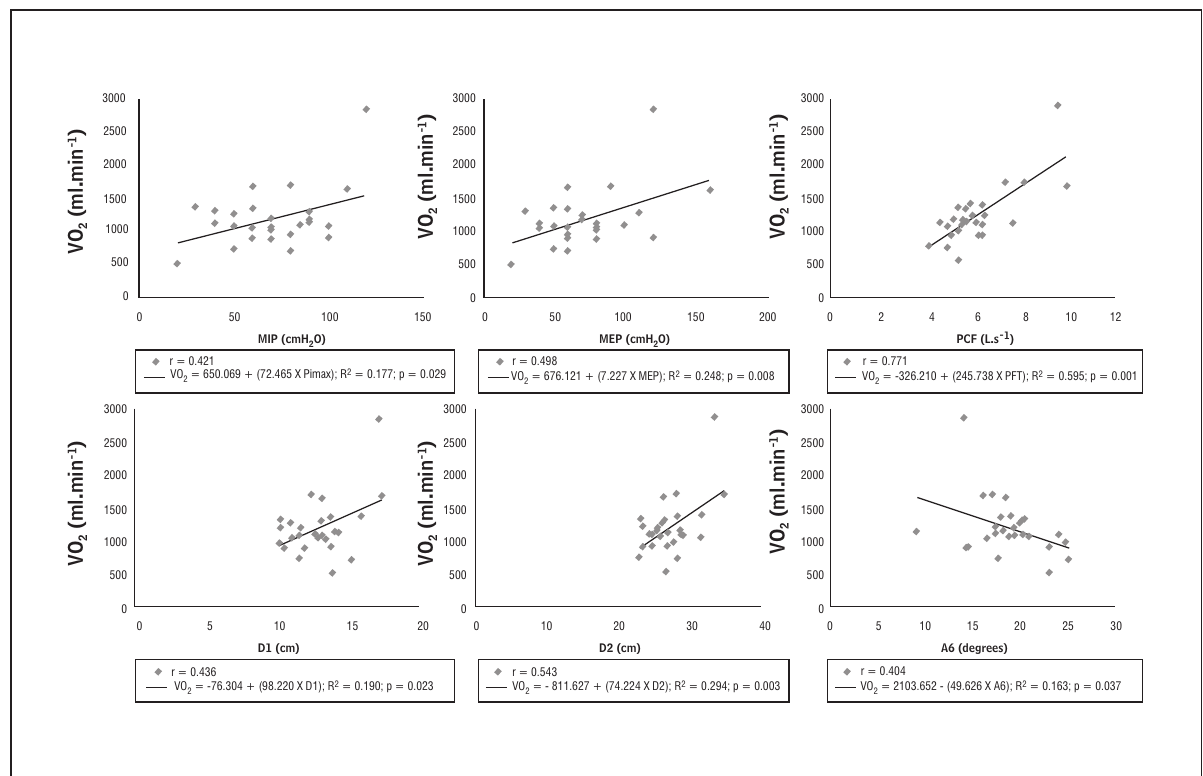
), maximal inspiratory pressure (MIP), maximal expiratory pres- Figure 4 – Significant correlations among oxygen uptake (VO 2 sure (MEP), peak cough flow (PCF), distance 1 (D1), distance 2 (D2) and angle 6